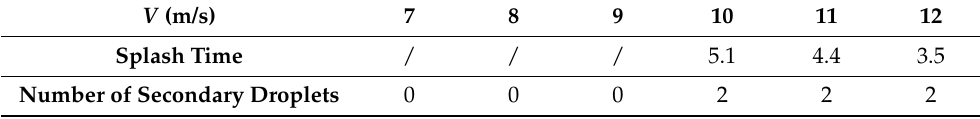
Table 1. Droplet splashing at different initial velocities (flat wire)/ μ s.